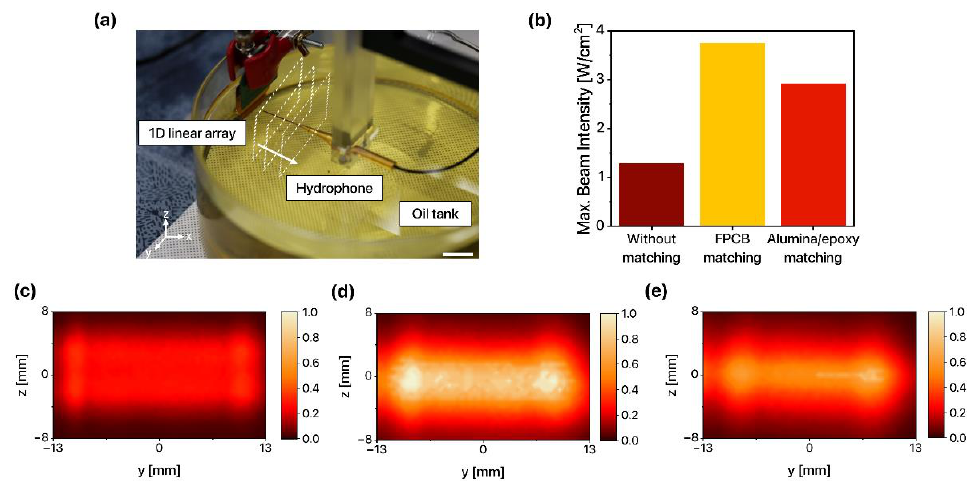
Figure 7. ( a ) Photo of the experimental setup for ultrasound beam profile measurement (scale bar: 1 cm). ( b ) Maximum ultrasound beam intensity and transversal ultrasound beam profiles of 1D linear ultrasound transducer arrays ( c ) without matching layer, ( d ) with the FPCB matching layer, and ( e ) with the alumina/epoxy matching layer.